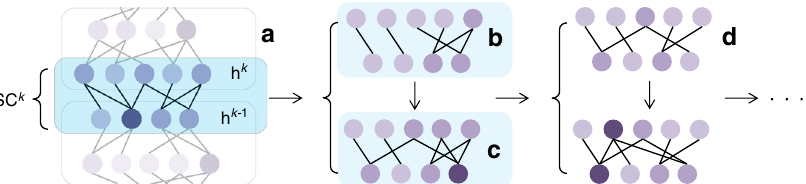
Fig. 1 An illustration of the SET procedure. For each sparse connected layer, SC k ( a ), of an ANN at the end of a training epoch a fraction of the weights, the ones closest to zero, are removed ( b ). Then, new weighs are added randomly in the same amount as the ones previously removed ( c ). Further on, a new training epoch is performed ( d ), and the procedure to remove and add weights is repeated. The process continues for a fi nite number of training epochs, as usual in the ANNs training